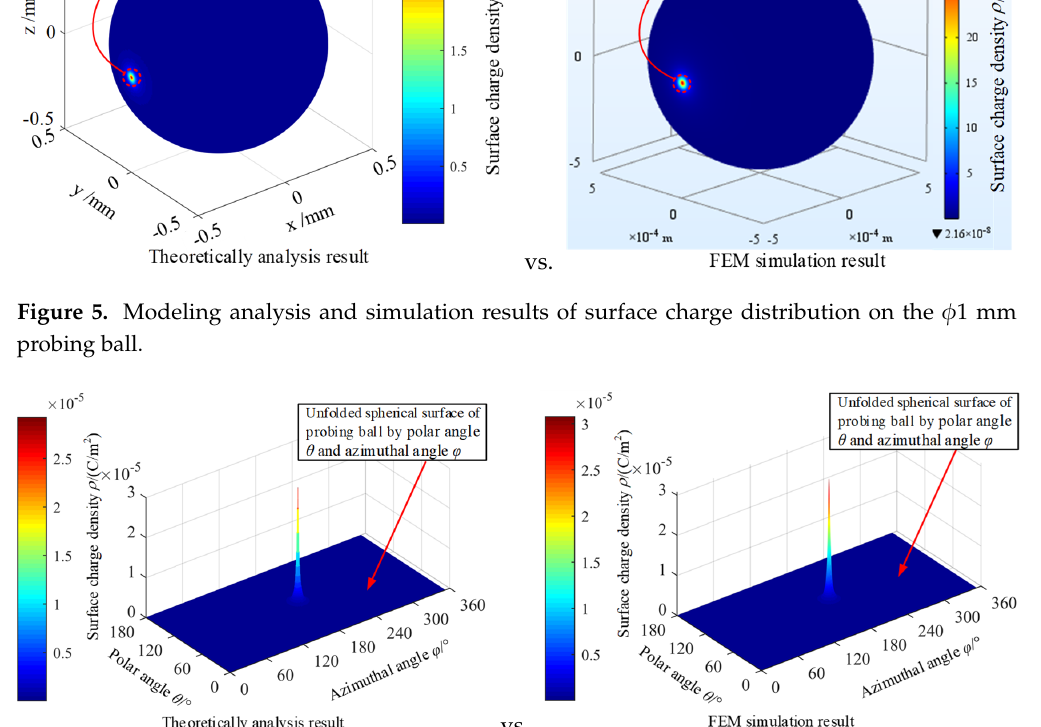
Figure 6. Modeling analysis and simulation results of surface charge distribution with the spherical surface unfolded.